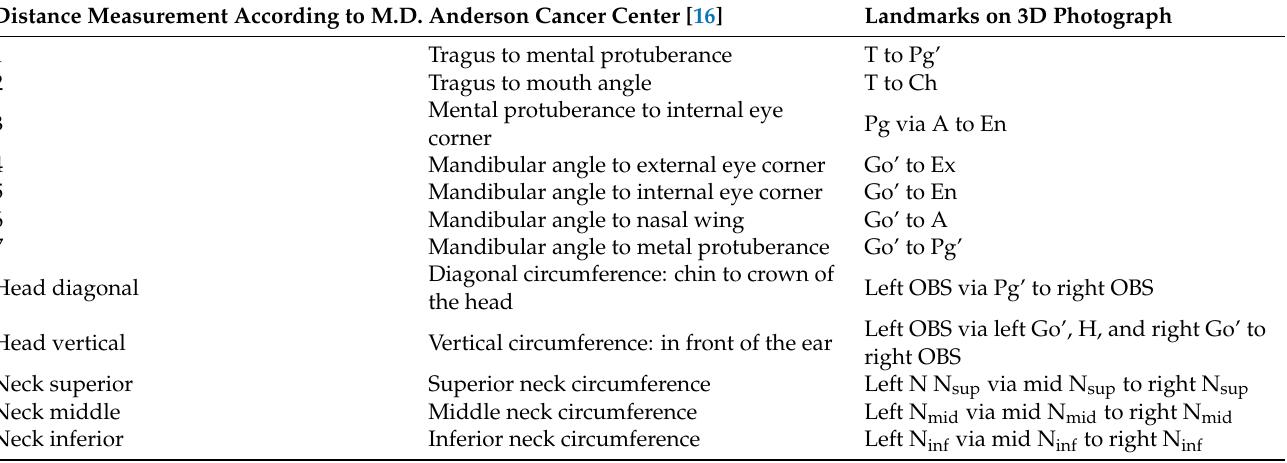
Table 2. Distance measurements performed on 3D photographs using facial landmarks (Table 1). Distance measurements 1–7 were performed on the right and left sides of the head, using the landmarks of the corresponding